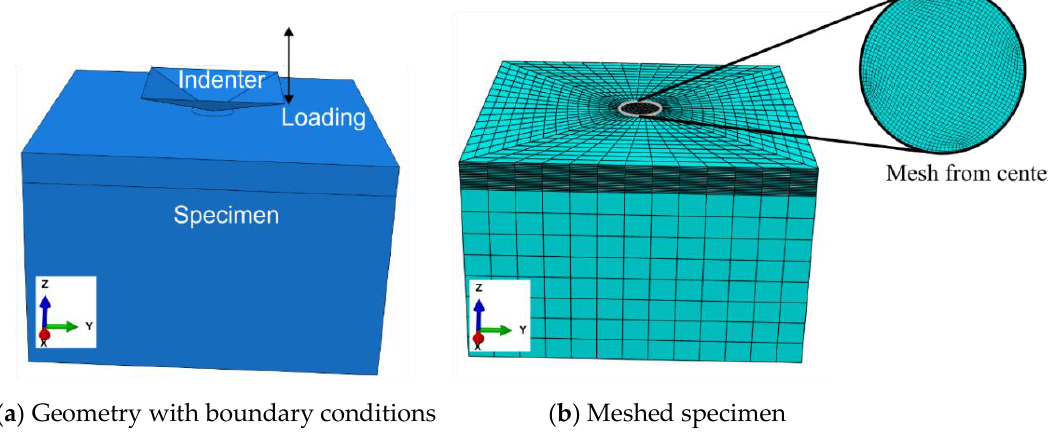
Figure 3. Details of the numerical model used. ( a ) Specimen is held fixed from the bottom and the indenter is placed in the center of the specimen that moves in and out during loading and unloading, respectively. ( b ) The fine meshing is performed at the center of the specimen.